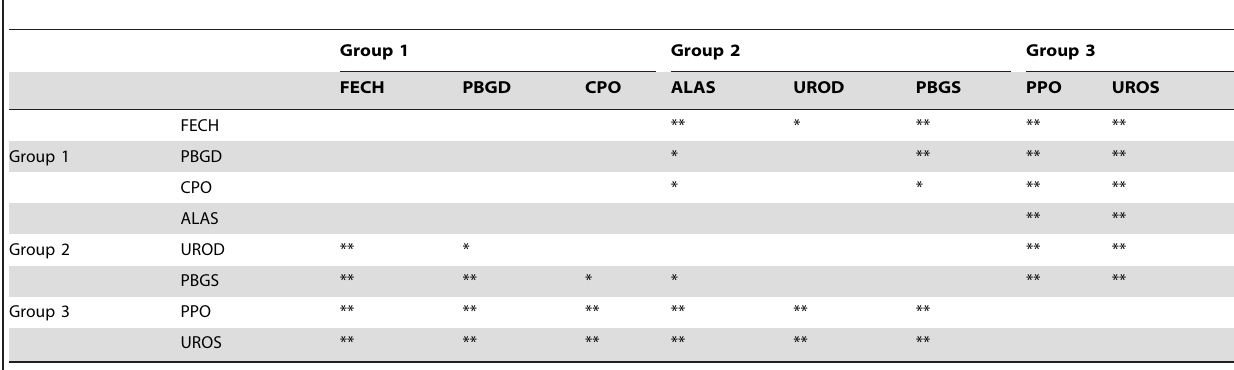
For each comparison, a pair of genes was chosen. v value of the gene in the row is constrained to the average value of omega values from the genes in the rows and columns. The difference in the likelihood between the null model M0 and the constrained model was obtained. The significance level is labeled * if p , 0.05 and ** if